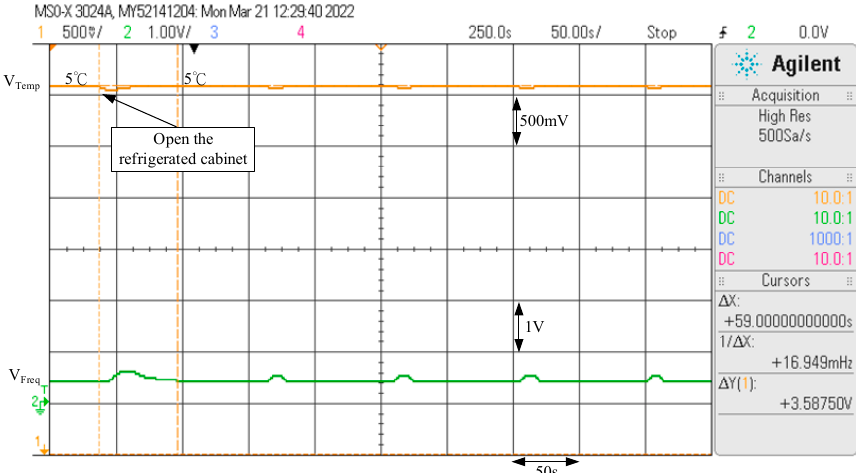
Figure 37. Response of the temperature control with the extension controller proposed.